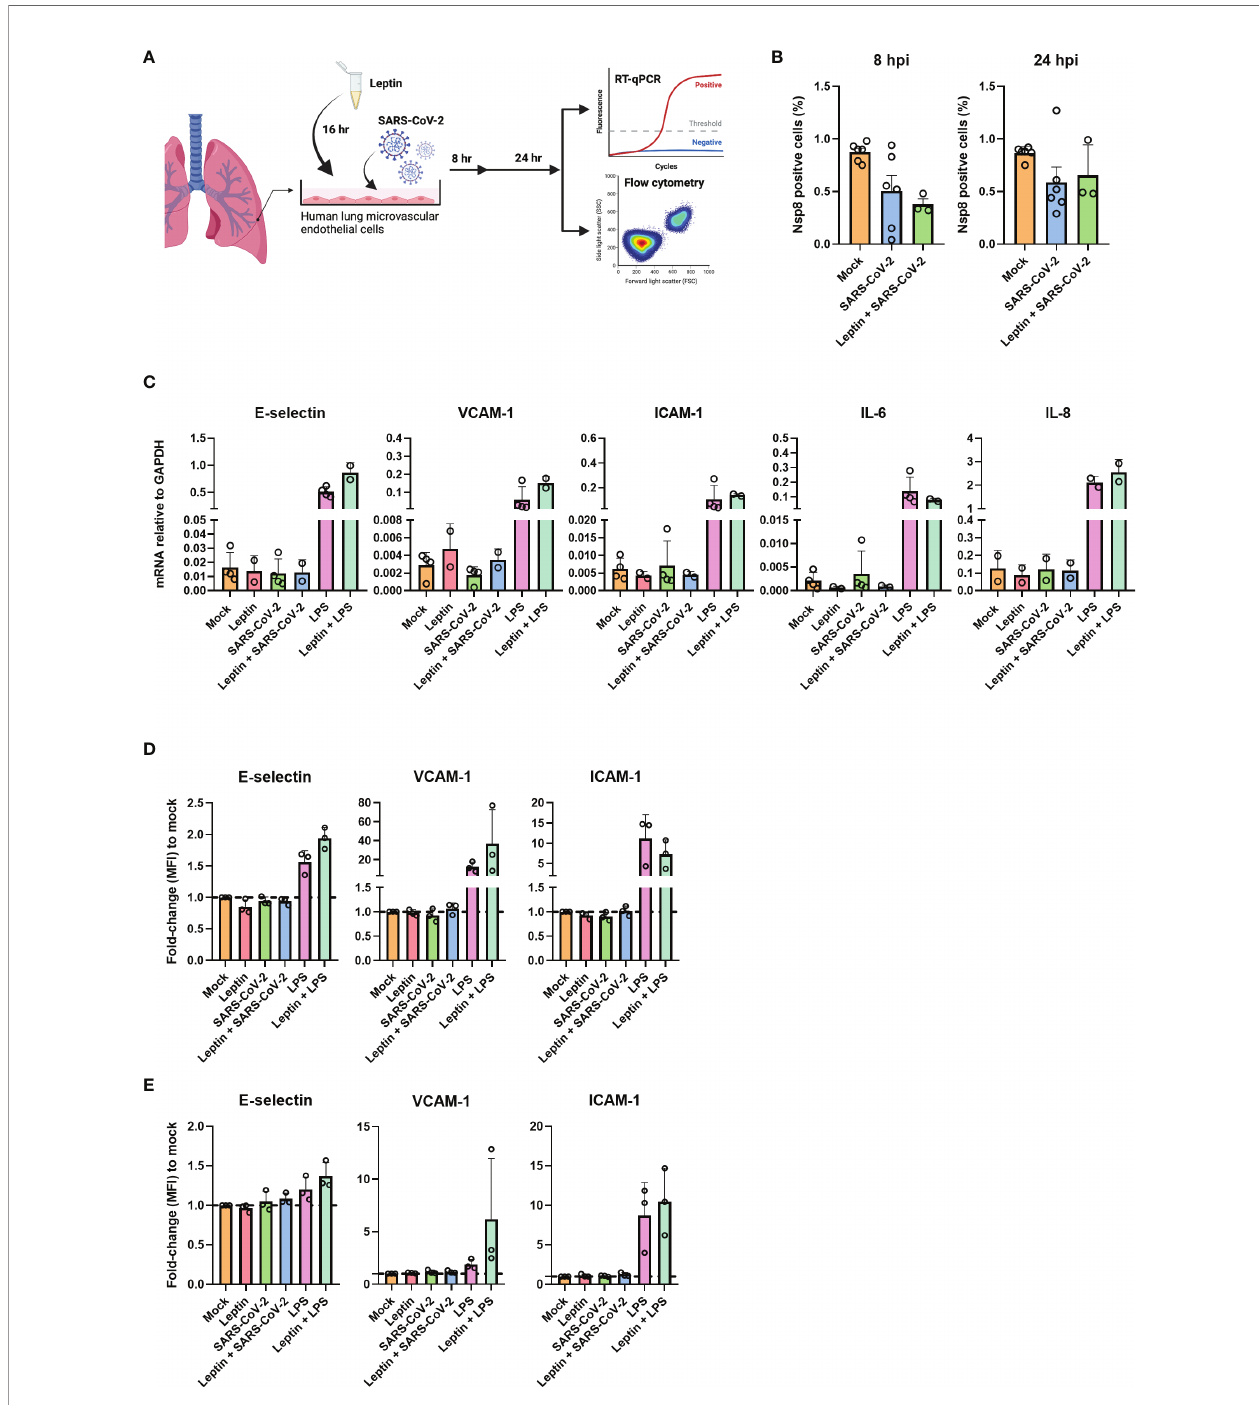
FIGURE 3 | Leptin does not facilitate infection or activation of HLMVEC. (A) schematic overview of the experimental set-up. HLMVEC were pre-incubated or with leptin, 1000ng/mL or with media for 16 hr. Cells were then inoculated with SARS-CoV-2 at MOI 5 or LPS 1µg/mL for 8 and 24 hr. (B) Percentage of infected cells were determined at 8 and 24 hpi by fl owcytometry. (C) Gene expression of E-selectin, VCAM-1, ICAM-1, IL-6, and IL-8 was determined by qPCR at 8 hpi. Results are expressed as the mean ± SD of 2-4 individual experiments done with duplicate technical replicates (D, E) Cells were analyzed for protein expression of E- selectin, VCAM-1 and ICAM-1 at 8 (D) and 24 hpi (E) by fl owcytometry. Data are represented as MFI fold-change to mock and represented as mean ± SD of at least three independent experiments. Each symbol represents data from a single independent experiment. Student T test was used to evaluate statistical differences and a p value ≤ 0.05 was considered signi fi cant with *p ≤ 0.05, **p ≤ 0.01 and ***p ≤ 0.001. In the absence of ‘ * ’ the data is non-signi fi cant. Figure 3A was created with